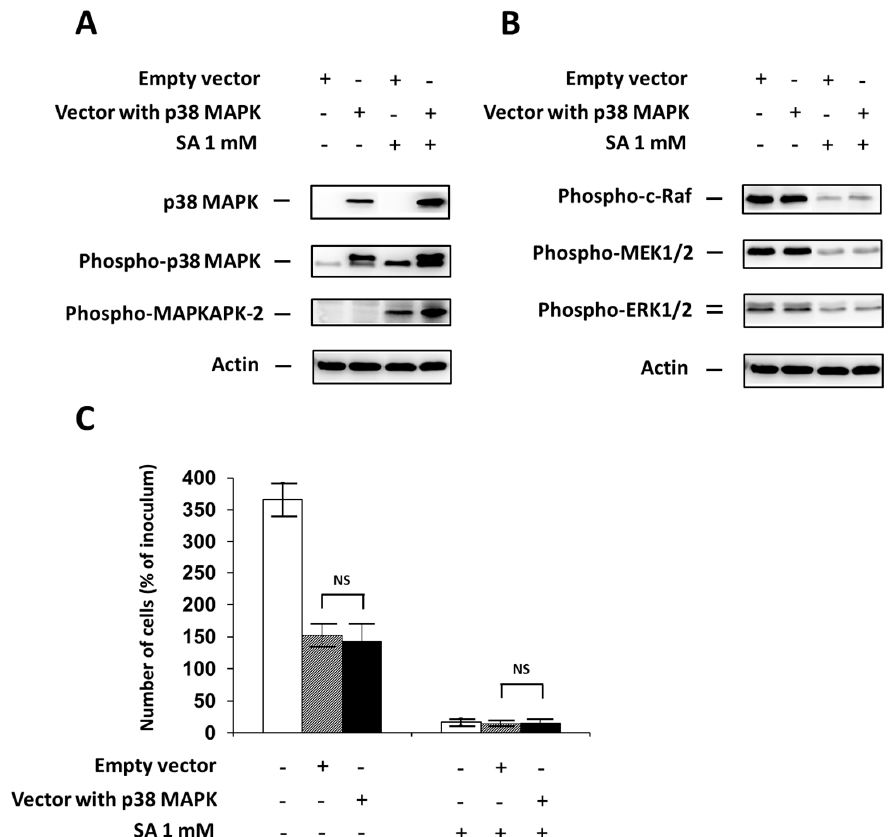
Figure 4. Effect of p38 MAPK overexpression, using transfection with a specific plasmid (Vector with